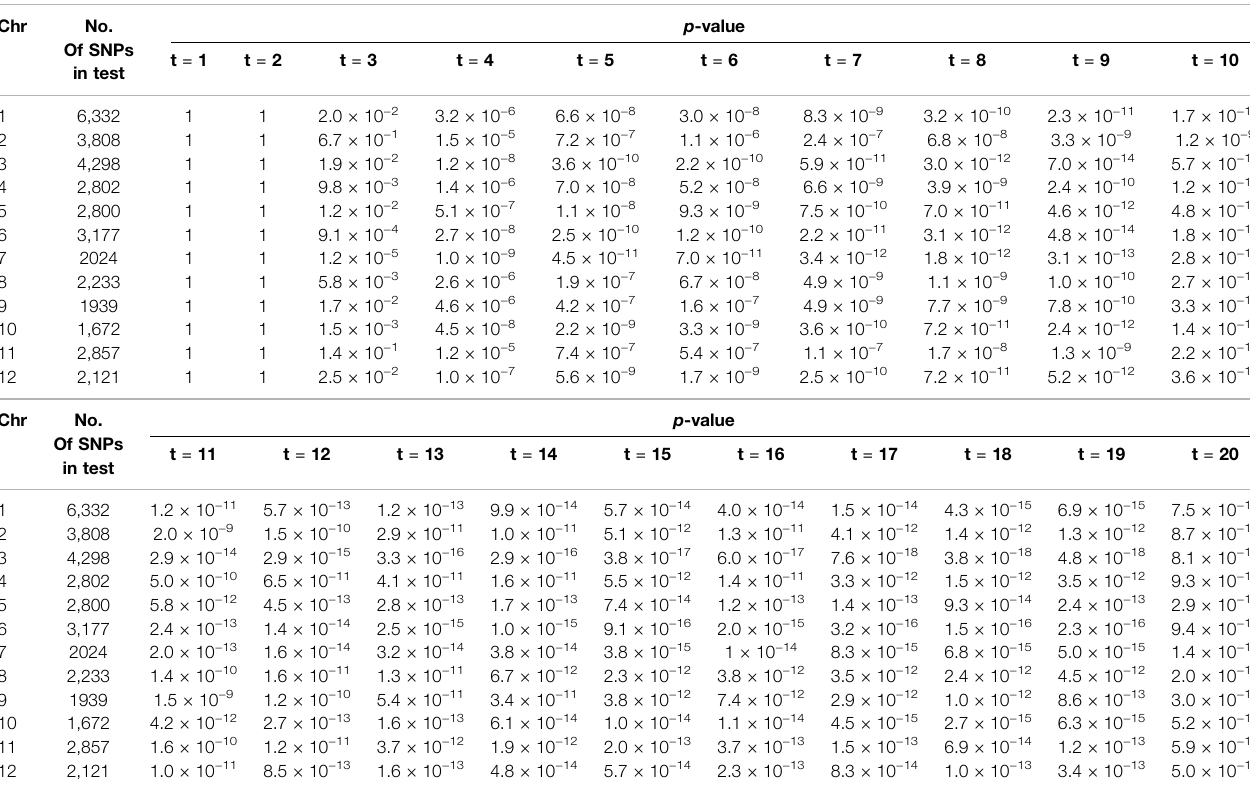
TABLE 10 | The number of SNPs and the p -value of the association analysis of each gene region based on LFDAT at signi fi cance level of 0.05 Chr No. Of